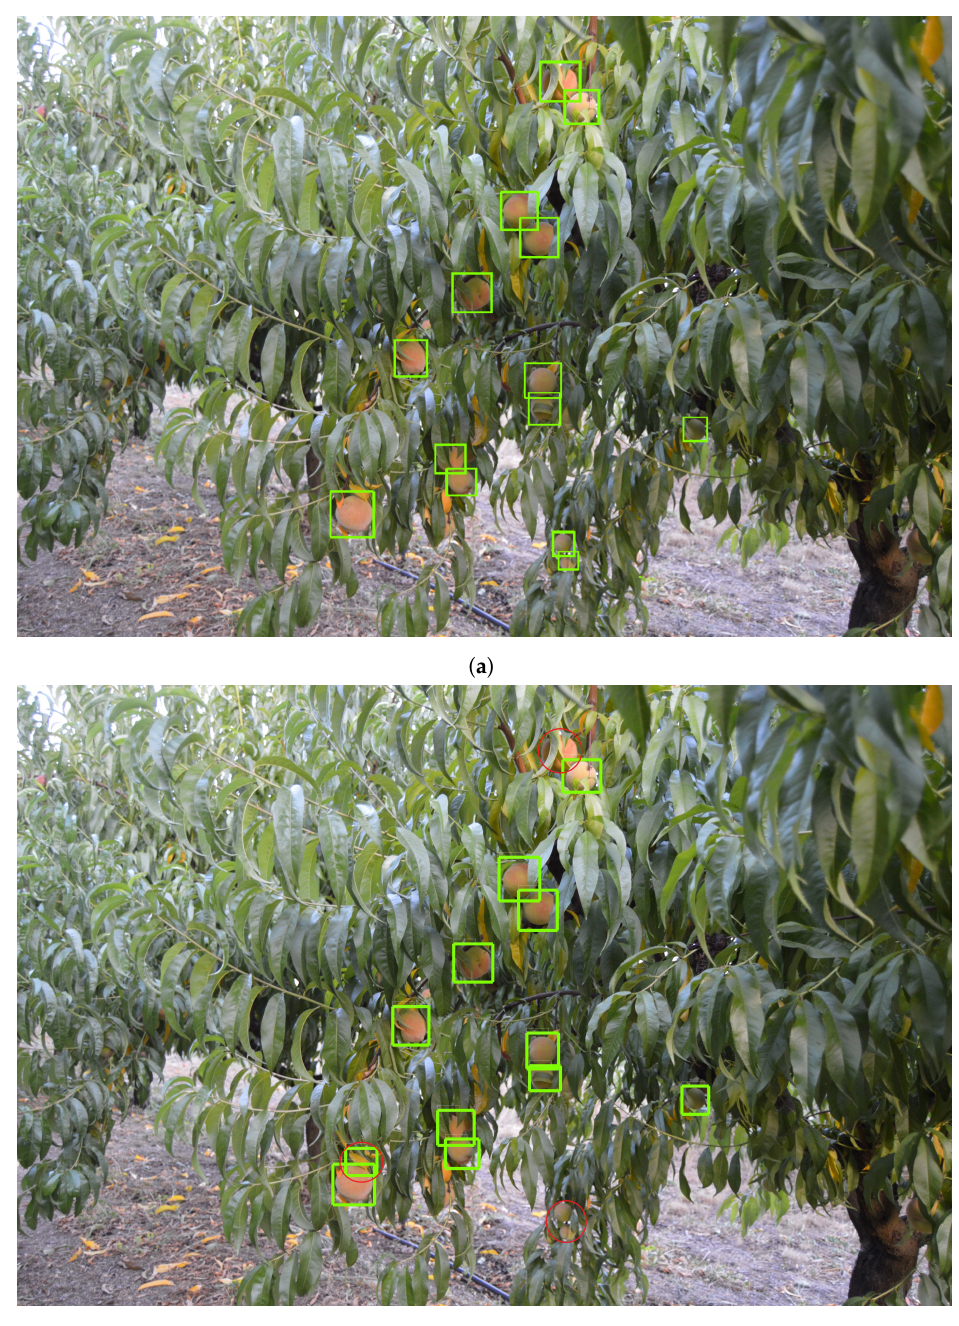
Figure 12. Test result in a different orchard (sample-3): ( a ) shows a test image and its manually annotated fruits; ( b ) shows the predicted fruits detection by the model. The green rectangular boxes are corrected detections, and the red circles are illustrative missing detections. Figure 13 has two special features: many yellow leaves and reddish fruits. Again, the model shows good generalization. For this image, there was only one miss detection for yellow leaves and one miss detection for occluded fruit. The model did well for clustered and red